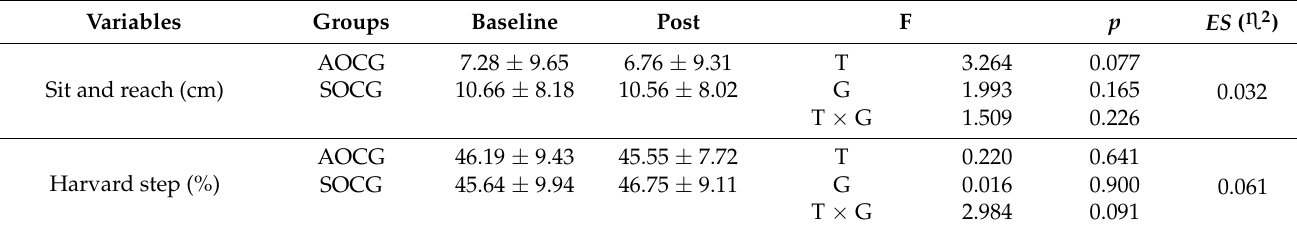
Table 3. Changes in flexibility and cardiorespiratory fitness. Table 1. Changes in body composition.